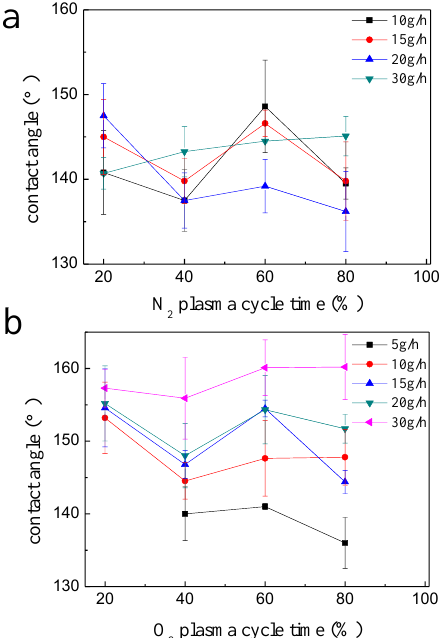
Figure 4. The CA of N 2 plasma-treated cotton ( a ) and O 2 plasma-treated cotton ( b ).